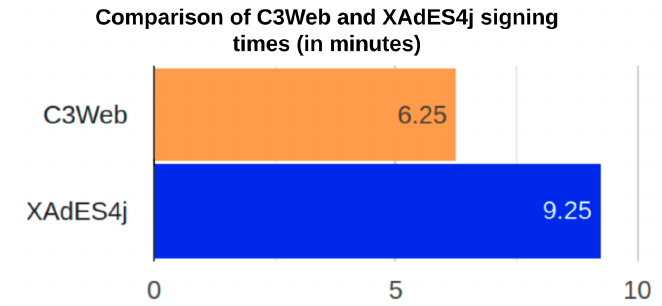
Figure 12. Signing